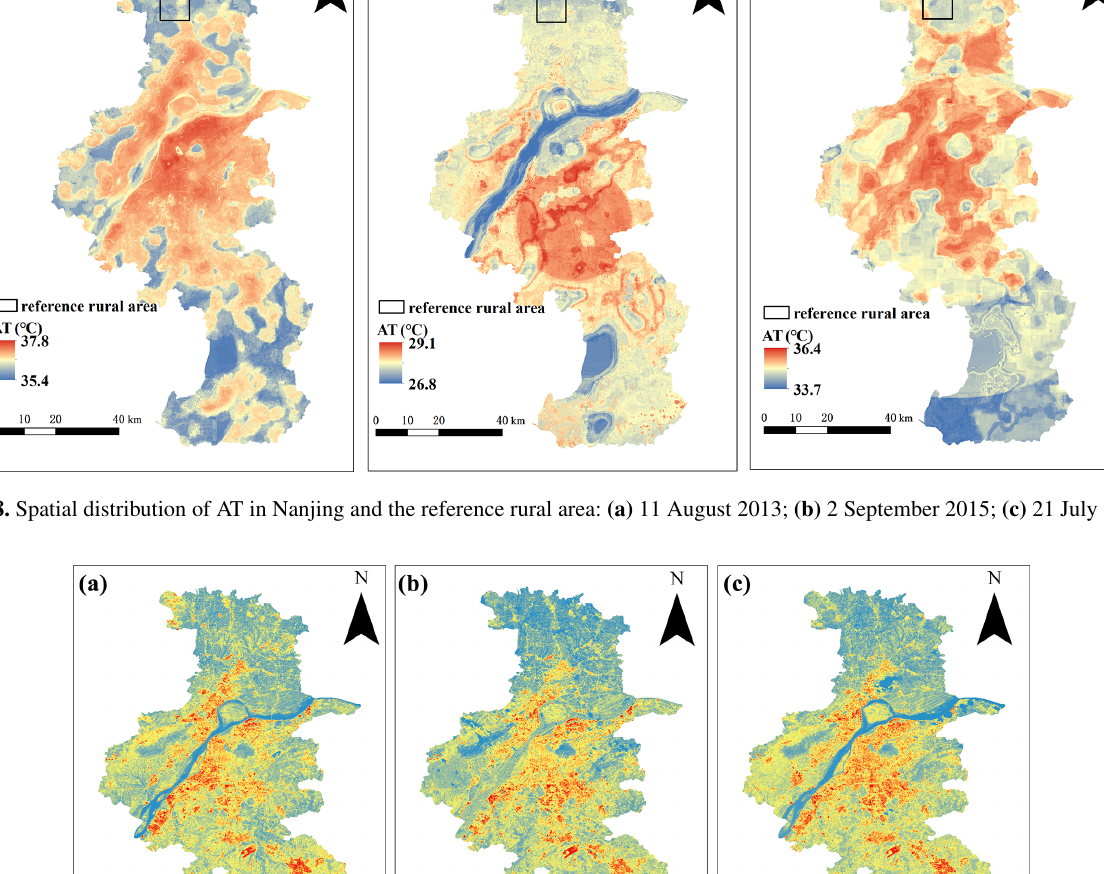
CUHII on 11 August 2013, the AT over the water bodies and large and strong cold island